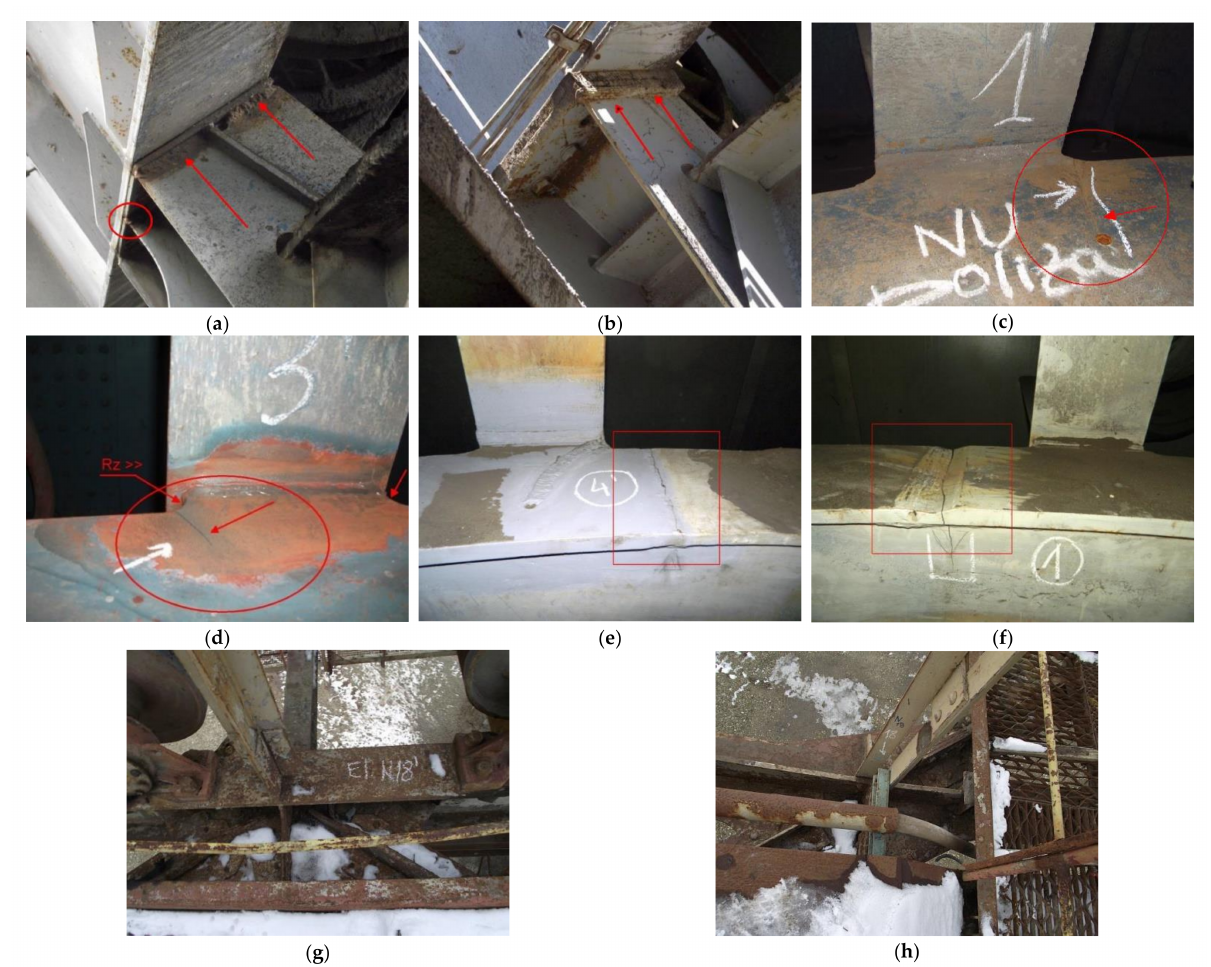
Figure 1. Various fissures and signs of corrosion in structural elements ( a , b ) Cracks of welded joints in bucket wheel support area caused by variable stresses; ( c , d ) Fissures caused by high roughness (Rz) value and material fatigue; ( e , f ) Cracks of welded joints in Heat Affected Zones (HAZ); ( g , h ) Corrosion of structural elements caused by exposure to environmental